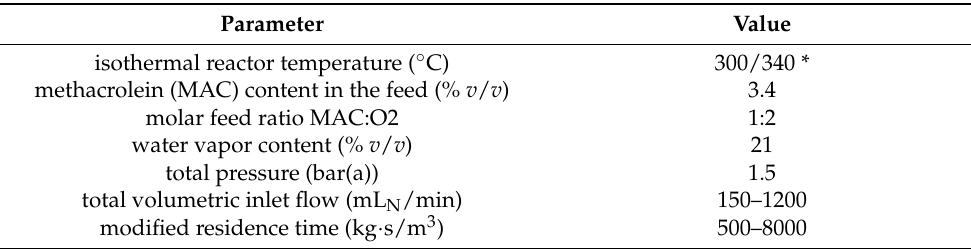
Table 5. Experimental conditions in the partial oxidation of methacrolein to methacrylic acid. Parameter